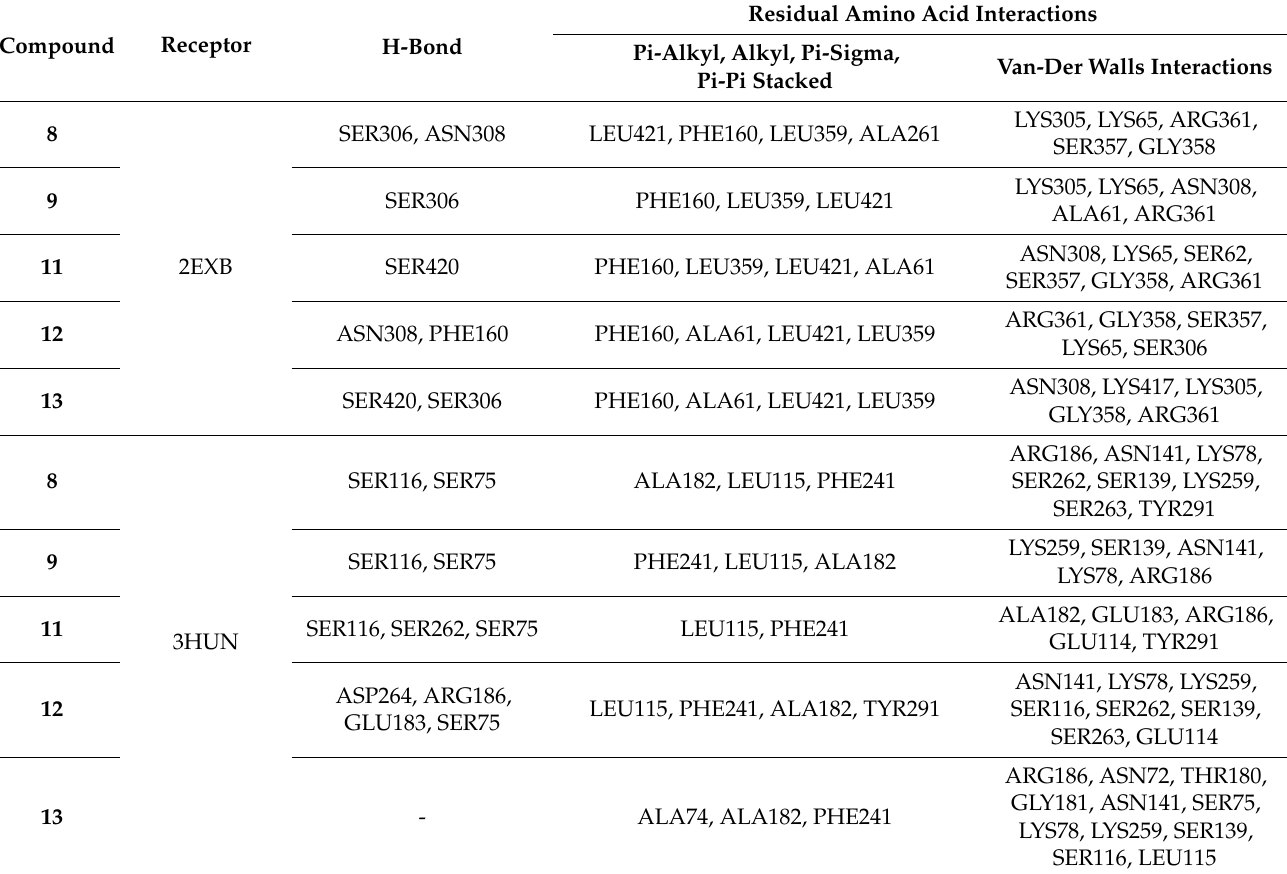
Table 2. Basic amino acid interactions and